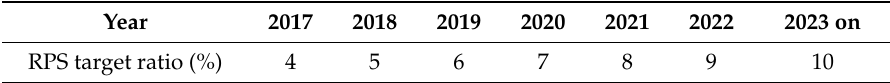
Table 1. RPS target ratio. (RPS: Renewable Portfolio